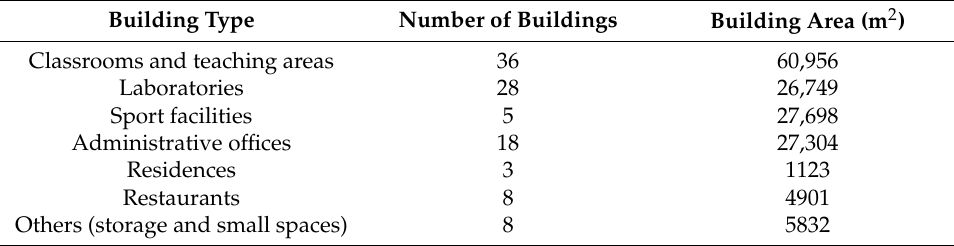
Figure 2. ESPOL campus area in Guayaquil and its buildings. Table 1. Number of buildings in ESPOL campus according to their type and total built-up area.